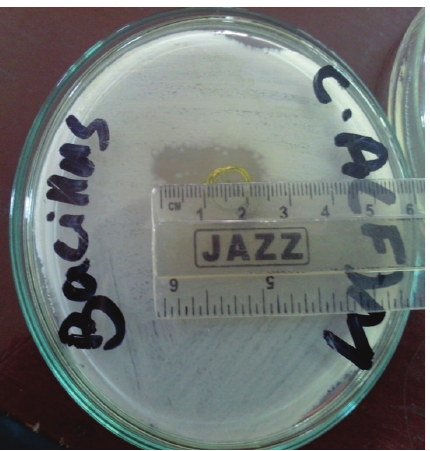
Figure 22: Zone of inhibition of methanol extract of fruit of C. ambrosioides L. against B. subtilis.